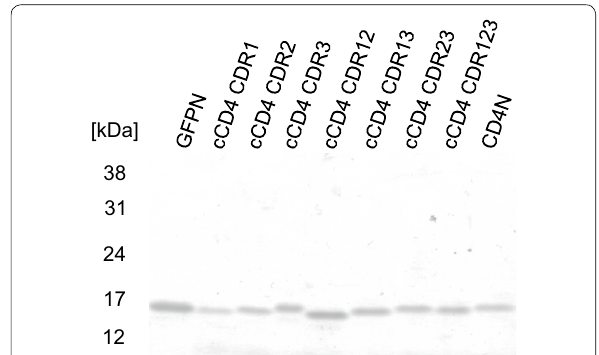
Fig. 3 Chimeric nanobodies detected in the culture supernatants of P. pastoris transformants. Culture supernatants of transformants (10 μL for each) were loaded. GFP N and CD4 N represents GFP- or CD4-nanobodies, respectively, tagged with long peptide tags containing two